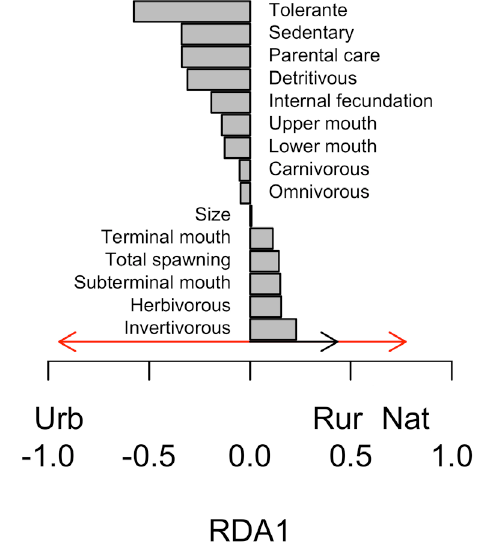
FIGURE 4 | Ordination scores of community-weighted means (CWMs) of traits (gray bars) and proportions of land use/occupation (arrows: biplot scores for constraining variables along of the first principal axis of the redundancy analysis – RDA1) applied to 24 streams sampled in the state of Paraná, TABLE 2 | Pearson correlation ( r ) values describing the correlations between functional diversity indices or community-weighted means (CWMs) of traits and the area proportions of land use/occupation in the 24 streams sampled in the state of Paraná, Brazil. Bold values indicate p < 0.05; p = significance. Proportions Native vegetation